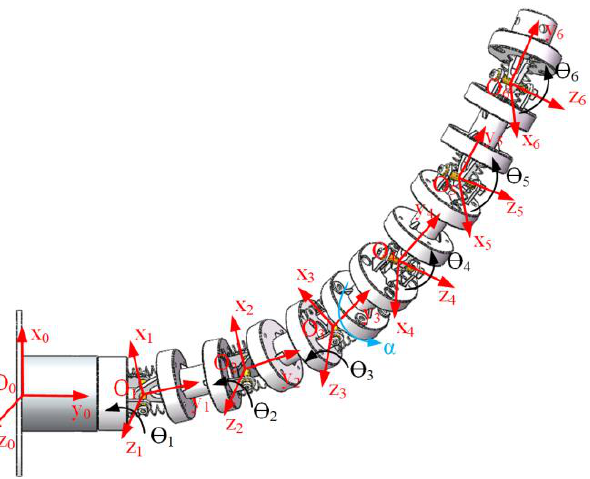
Figure 8. The coordinate transformation from base coordinate to end coordinate.